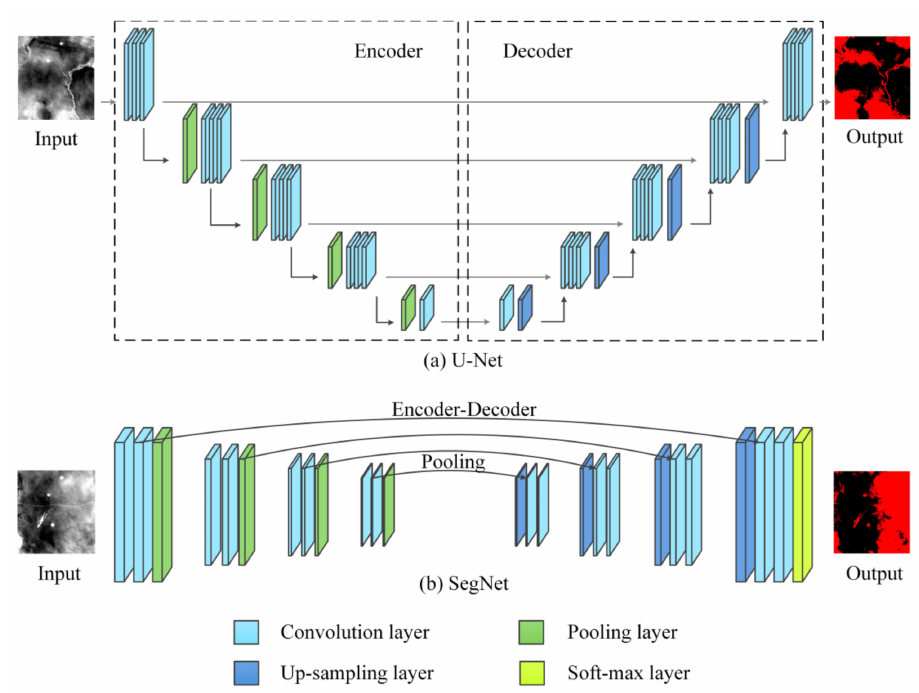
Figure 3. Diagram of U-Net and SegNet network